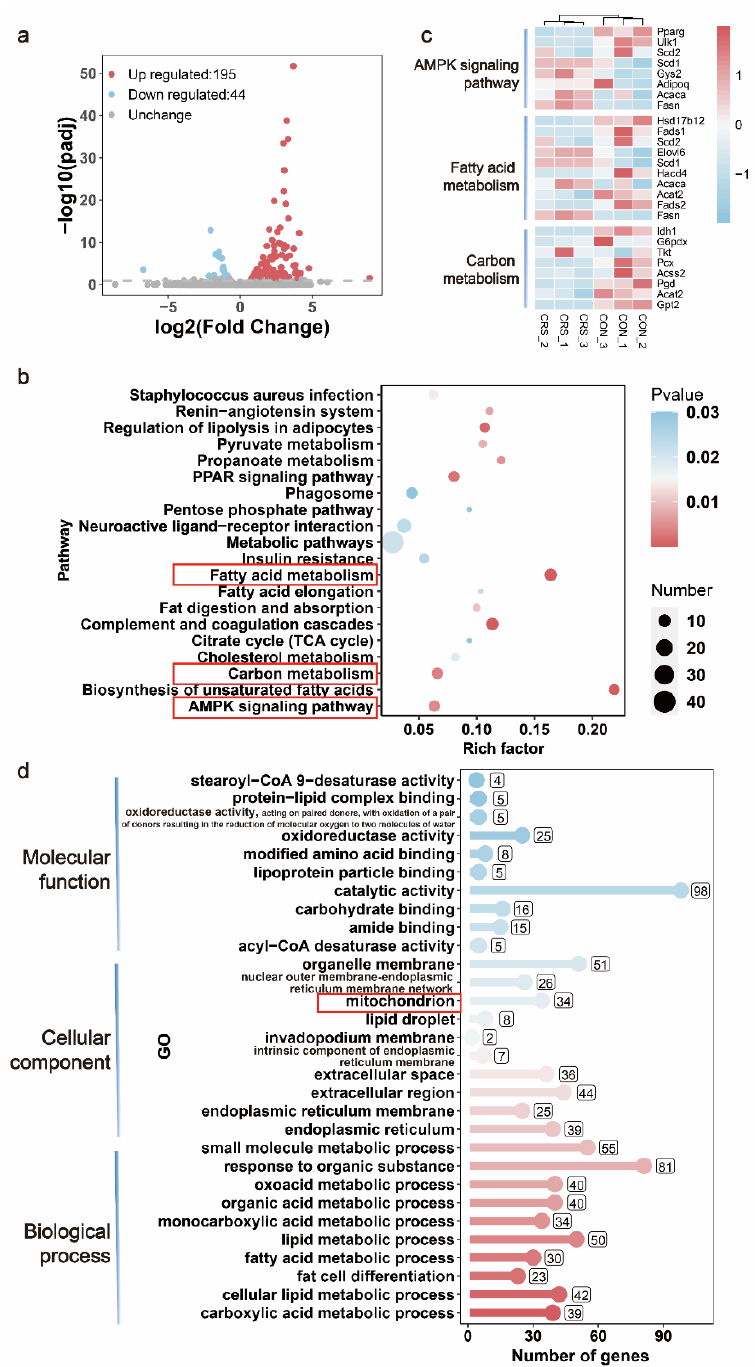
Figure 4. Effects of CRS on gene expression in the gastrocnemius of mice, by RNA-Seq data. Volcano map of the DEGs and their regulation ( a ). Heatmap of the AMPK signaling pathway, fatty acid metabolism, and carbon-metabolism-related DEG expression ( b ). KEGG ( c ) and GO ( d ) analyses of 239 specific DEGs in the gastrocnemius. n = 3 per group.